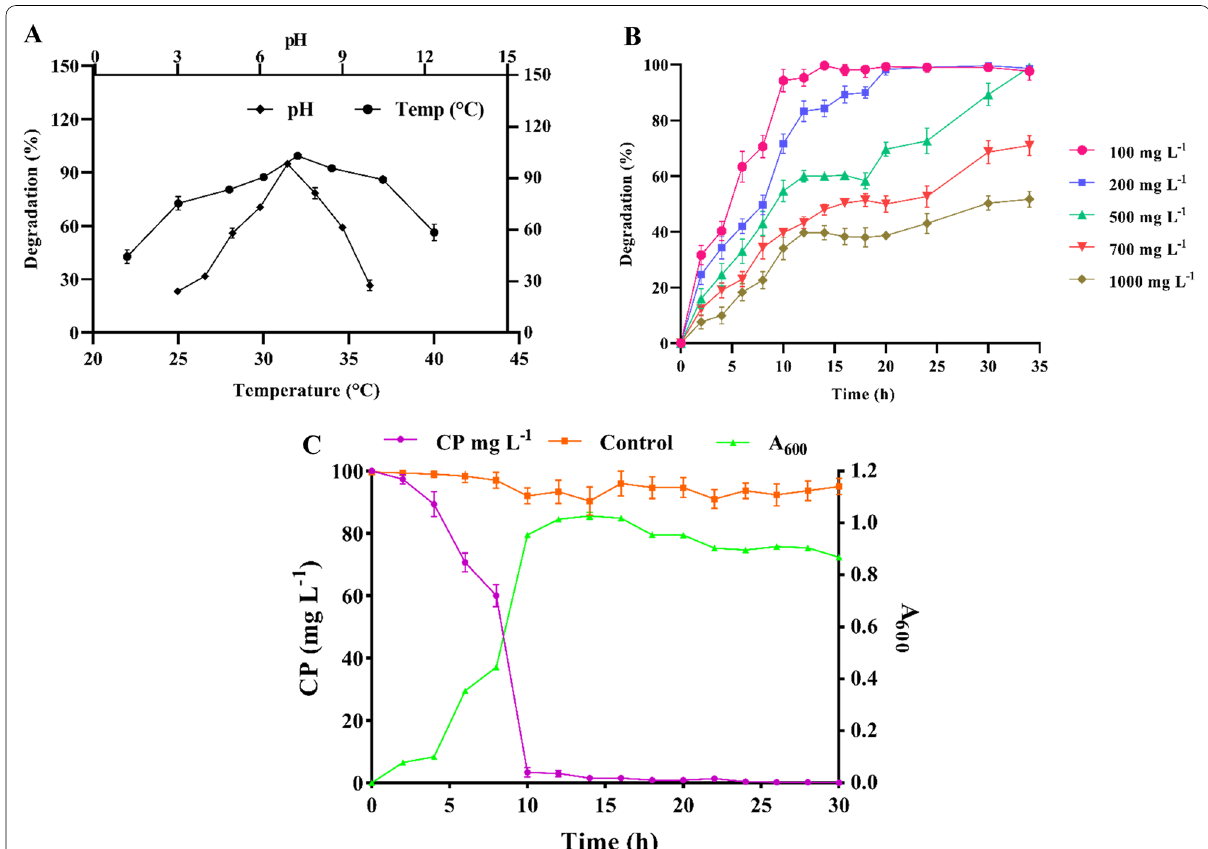
Fig. 3 Effect of environmental factor on CP degradation by Arthrobacter sp. HM01. A Effect of pH and temperature, B tolerance of HM01 towards CP concentration from 100 to 1000 mg L − 1 , C degradation profiling of CP by HM01 (100 mg L − 1